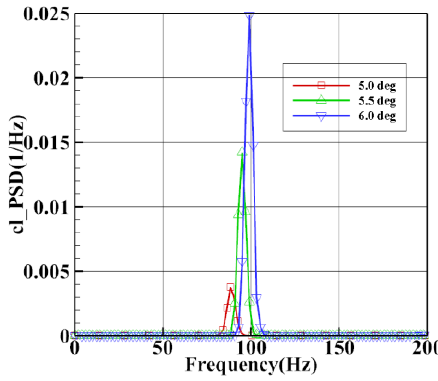
Figure 11. Power spectrum density (PSD) results at different incidence angles.